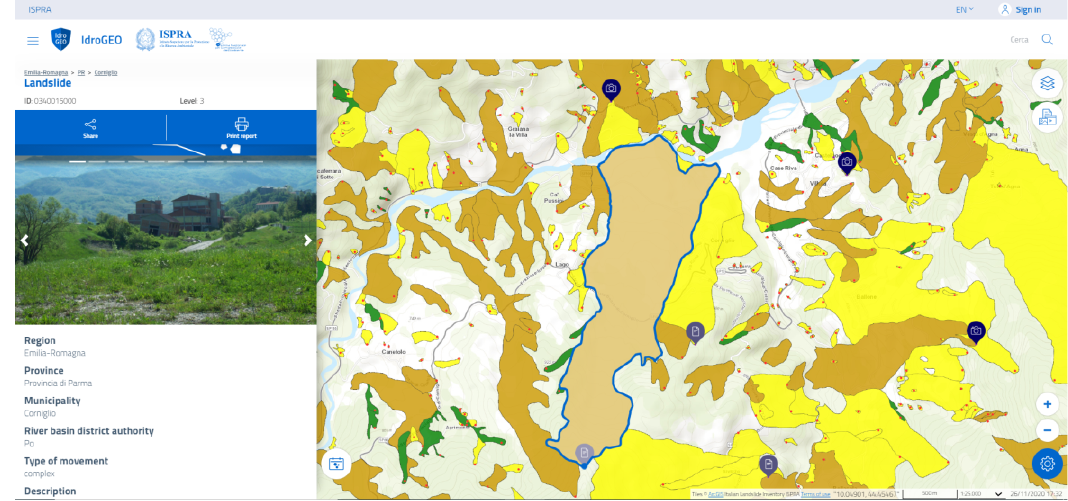
Figure 4. IdroGEO platform—Italian landslide inventory (IFFI)) section: information and multimedia on a single landslide.